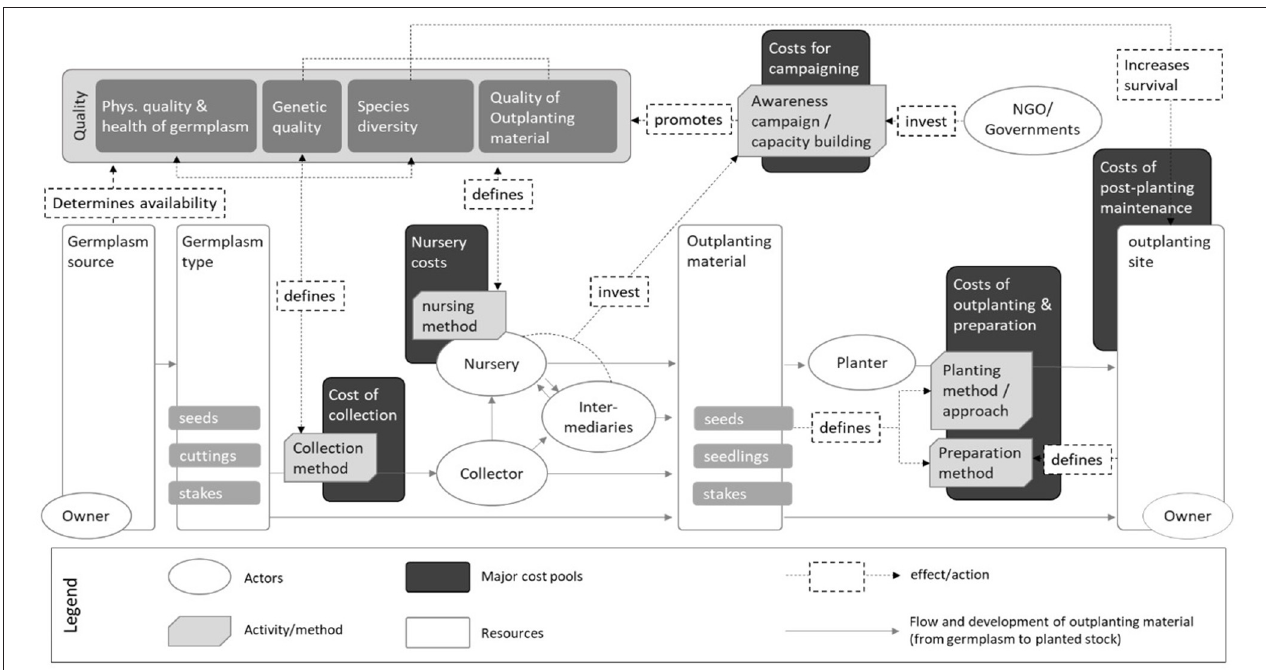
FIGURE 1 | Cost framework for major activities and cost pools relating to tree seed and seedling supply systems for the implementation of tree-based restoration.